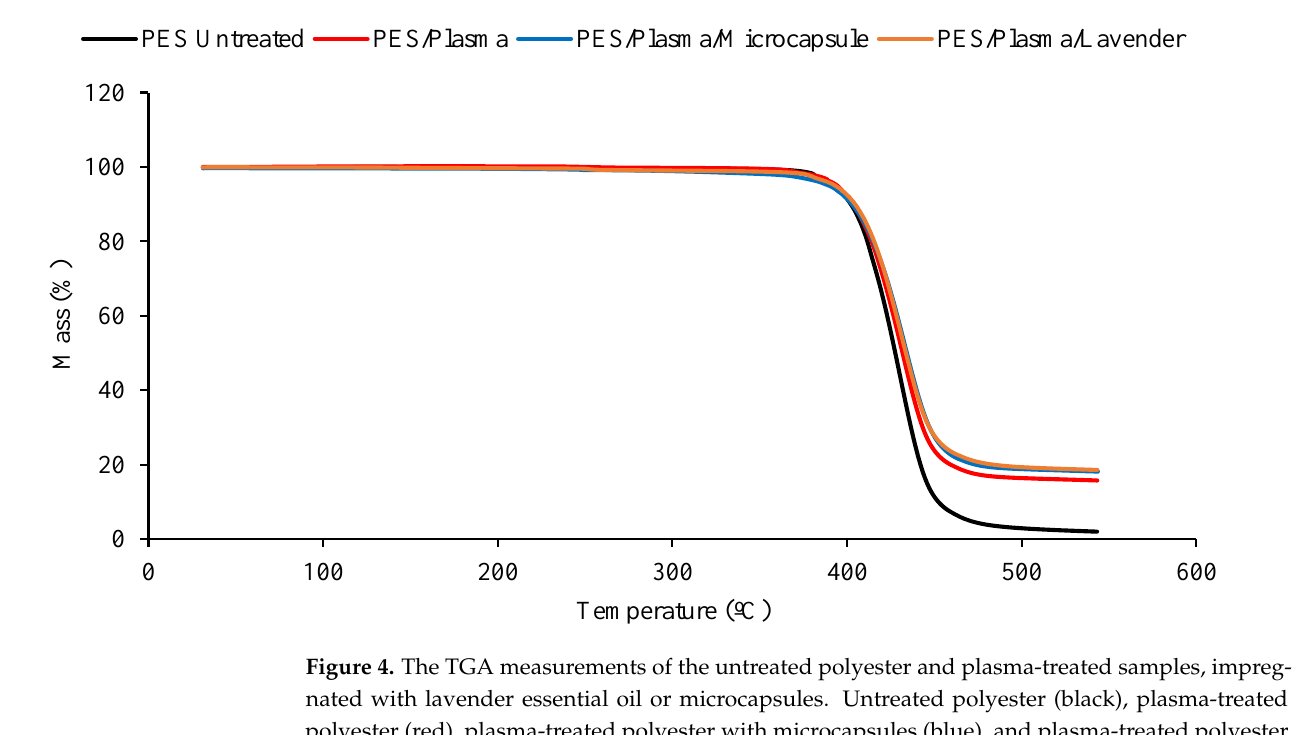
Figure 4. The TGA measurements of the untreated polyester and plasma-treated samples, impreg- nated with lavender essential oil or microcapsules. Untreated polyester (black), plasma-treated polyester (red), plasma-treated polyester with microcapsules (blue), and plasma-treated polyester with the lavender essential oil (brown).